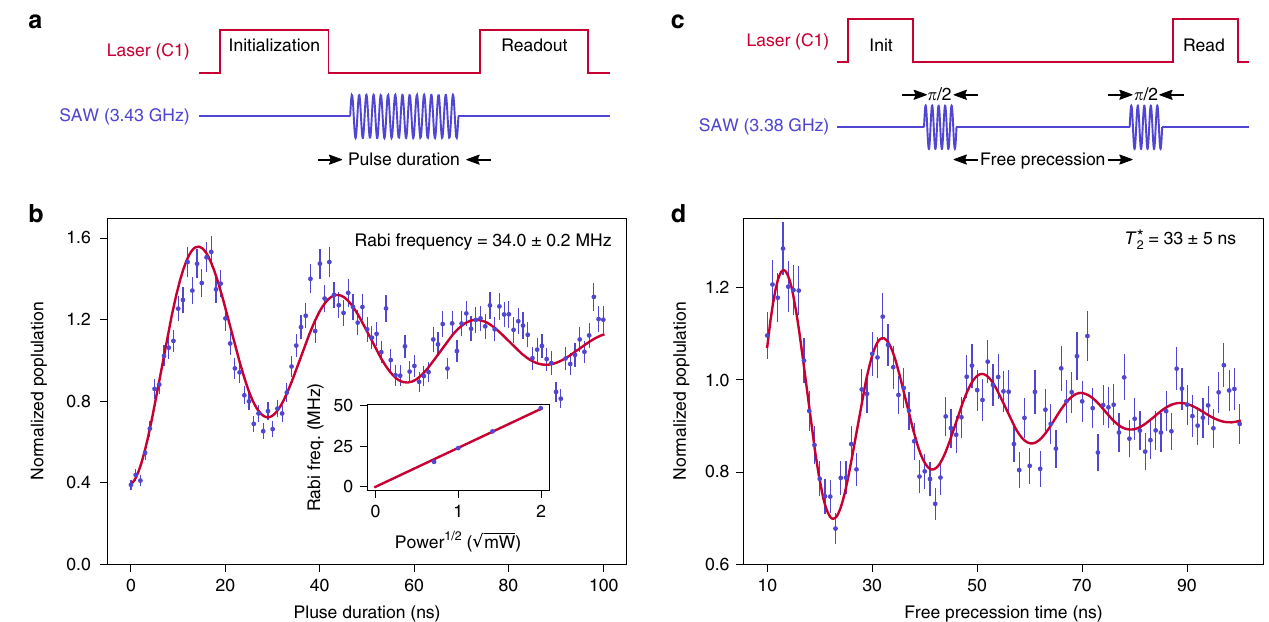
Fig. 4 Coherent acoustic control of the SiV spin qubit. a Pulse sequence used for Rabi oscillation measurements. An acoustic pulse of frequency 3 : 43 GHz, which is resonant with the SiV spin transition and generated with 2 mW peak microwave input power, is used to coherently drive the qubit. b Normalized population in the #j i state as the acoustic pulse duration is varied. A fi t to a theoretical model is shown in red. (Inset) The dependence of Rabi frequency on the square root of peak microwave input power indicates the expected linear behavior. The errors in the Rabi frequencies are of the order of 0 : 1 MHz. c Pulse sequence used for Ramsey interferometry measurements. Two π = 2 acoustic pulses, each detuned by 50 MHz and generated with 4 mW peak input power, are separated by a varying free precession time. d Normalized population in the #j i state as the free precession time is varied. A fi t to a theoretical model is shown in red. The time constant of the exponential decay of the oscillations gives a spin coherence time T (cid:5) in b and d represent the standard deviation of the normalized